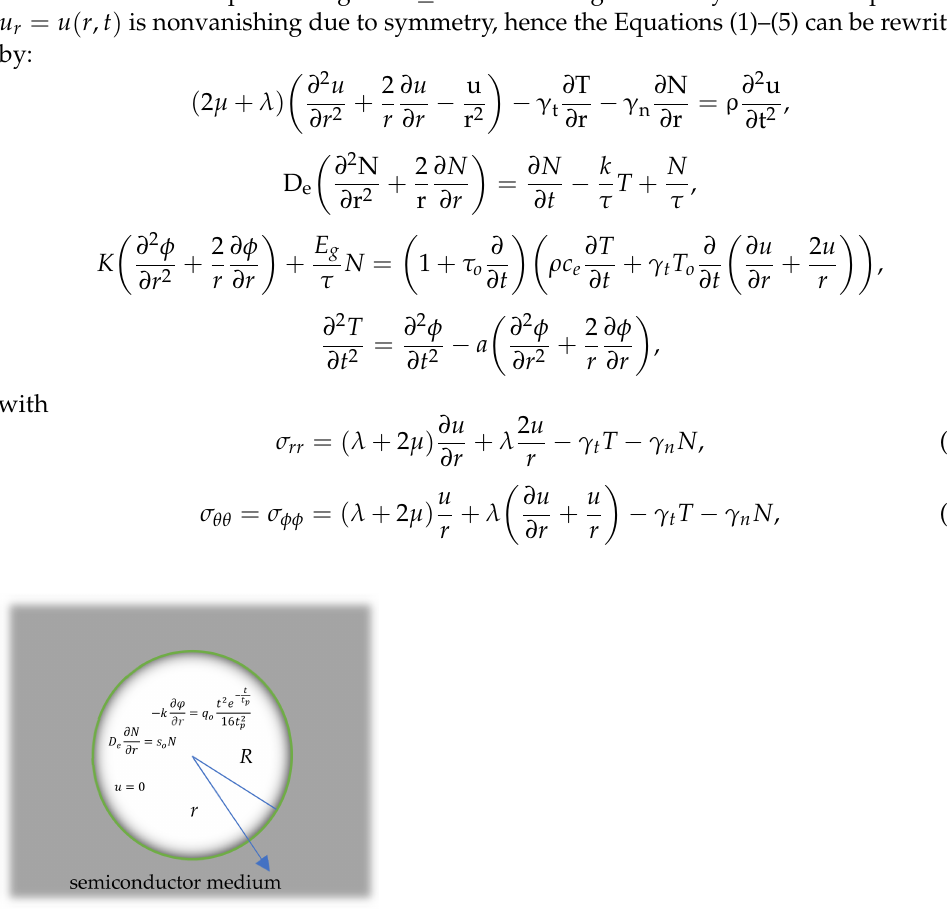
Figure 1. The sketch of a semiconductor medium with a spherical